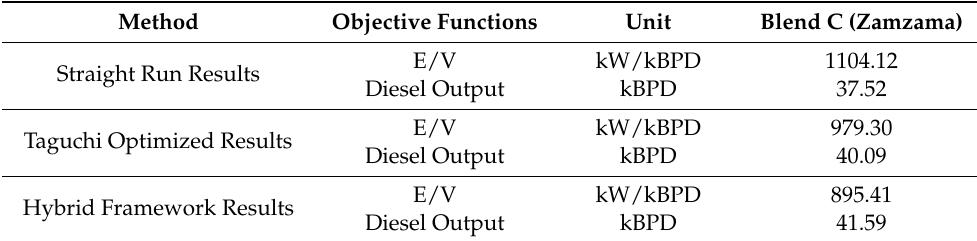
Table 7. Result comparison of straight run, Taguchi method, and hybrid framework for blend C (Zamzama Crude) [21].